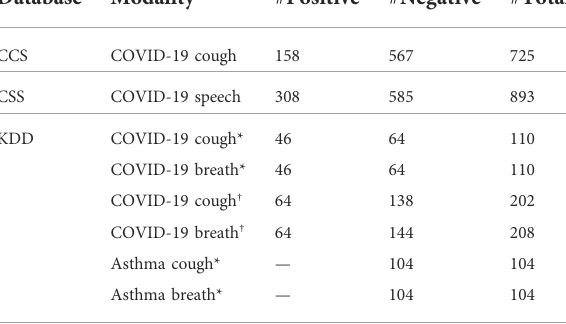
TABLE 1 Sample distribution of the databases utilized in our experiments with respect to modality, number of COVID-19- positive samples ( #Positive ), number of COVID-19-negative samples ( #Negative ), and total number of samples ( #Positive + #Negative , # Total